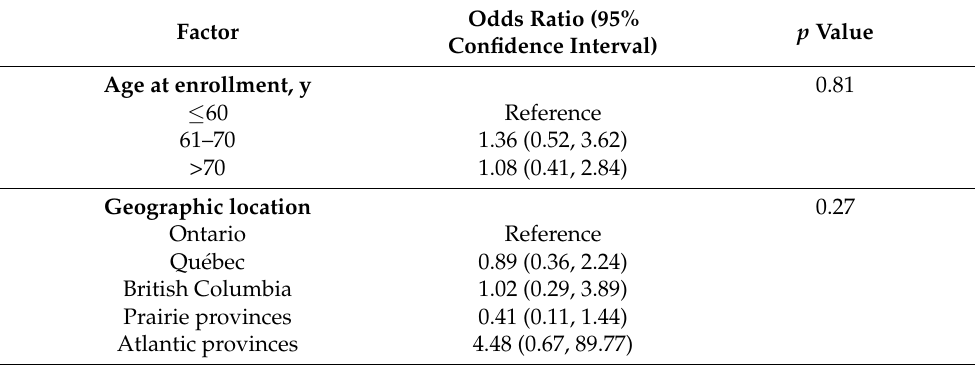
Table 4. Multivariable logistic regression analysis of predictors of trifluridine/tipiracil treatment of at least two